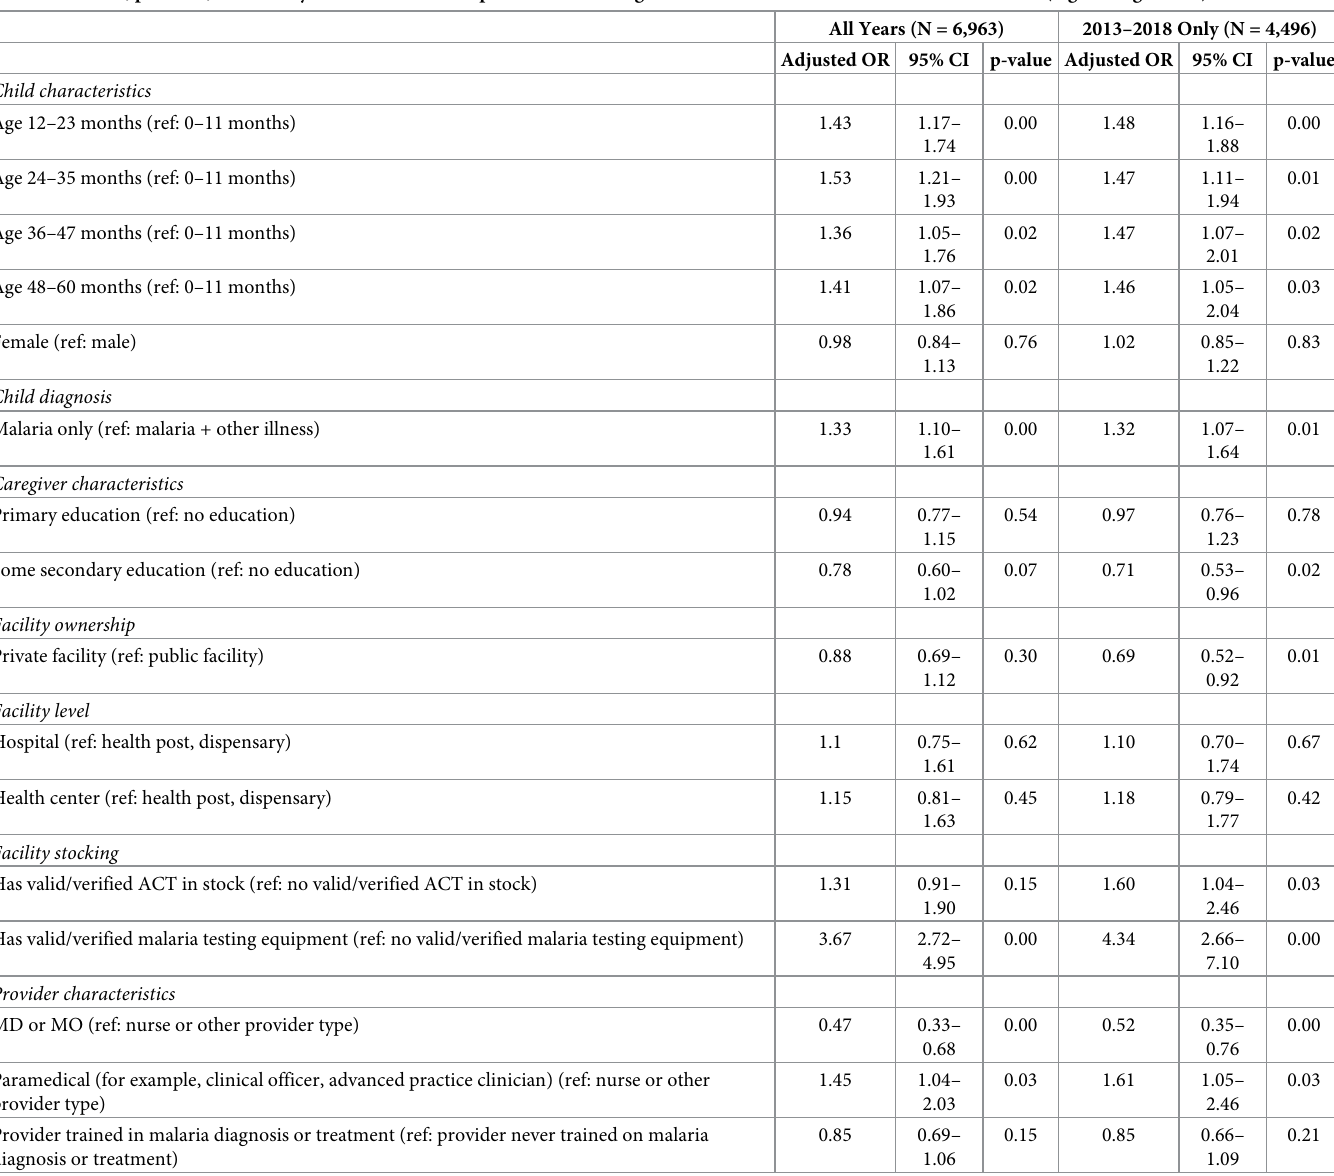
Table 3. Patient, provider, and facility correlates with receipt of blood test diagnosis and recommended medication for malaria (logistic